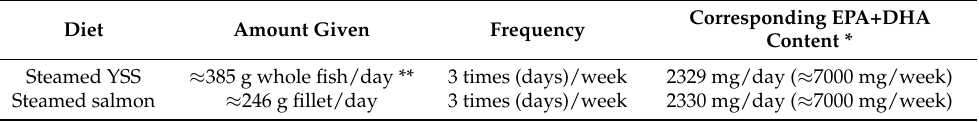
Table 1. Amount of fish